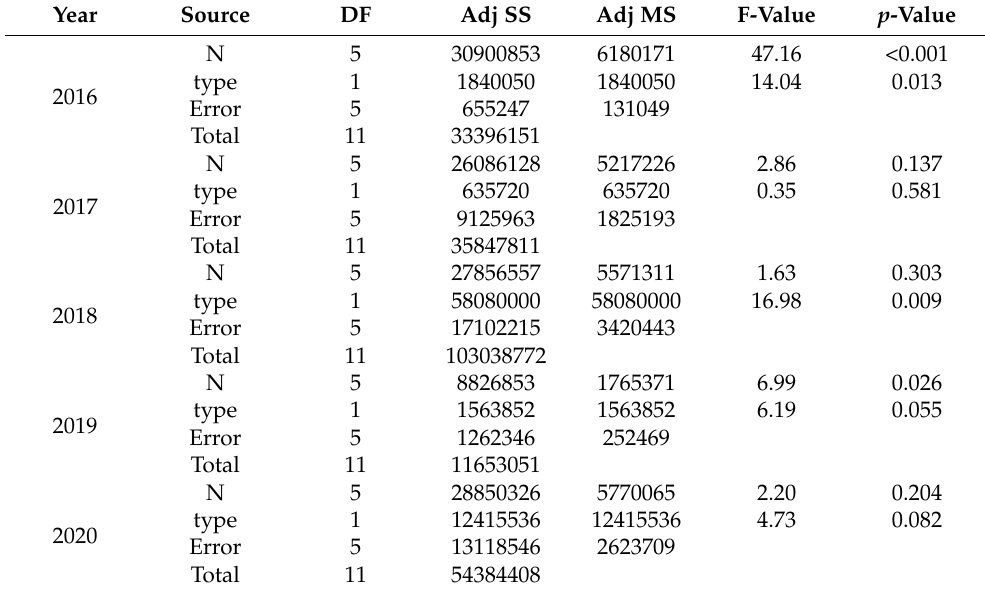
Table 13. Simple variance analysis on yield.